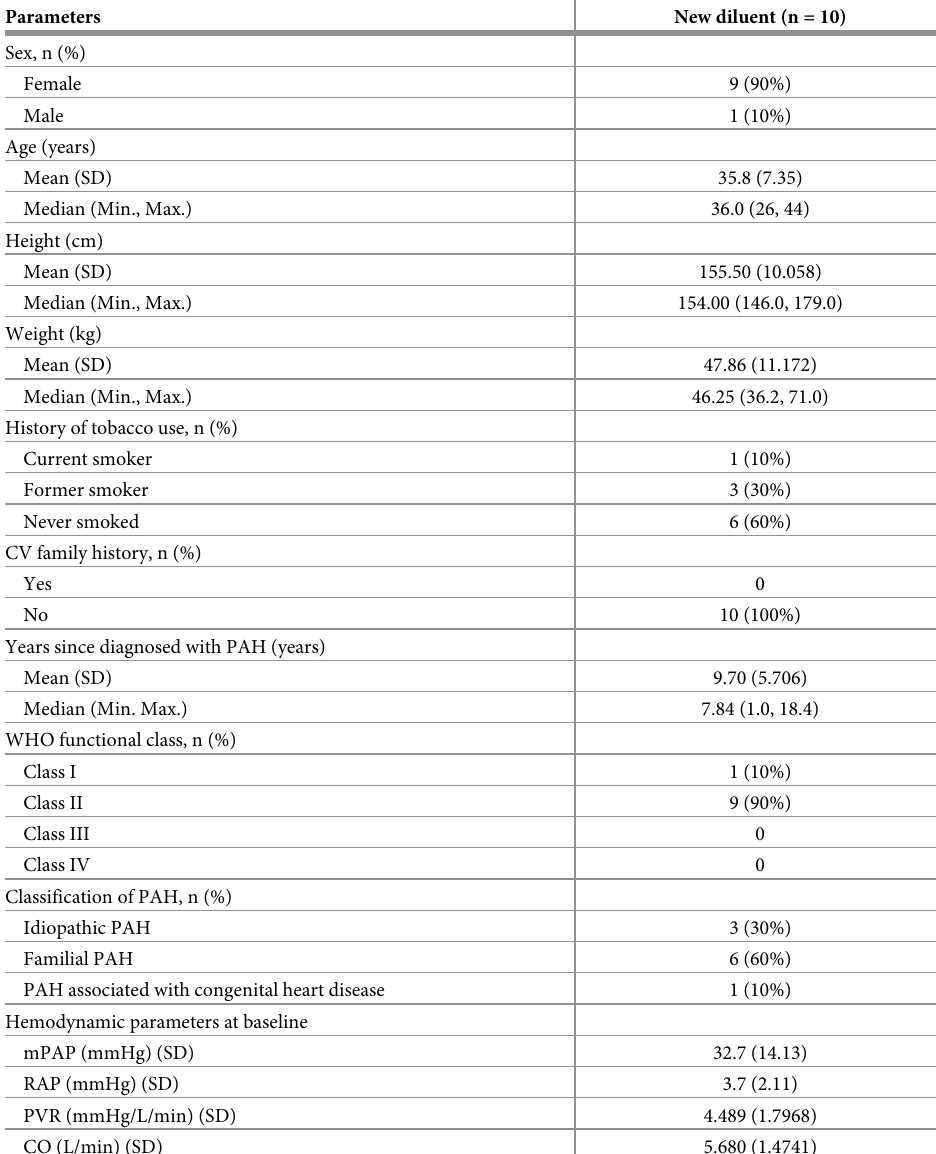
Table 1. Patient